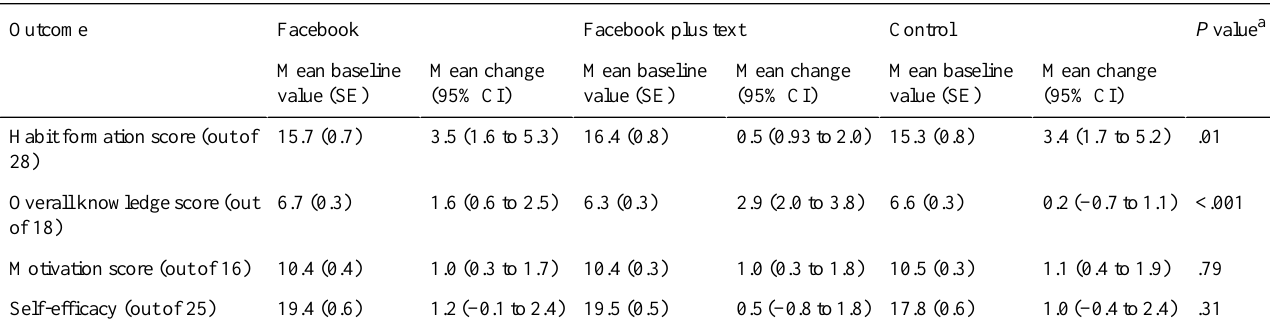
Table 5. Change in secondary outcomes from baseline to the end of the intervention for all participants (n=209, using imputed dataset).